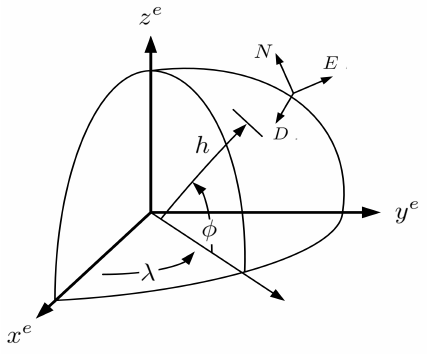
Figure 4. Earth-Centered Earth-Fixed co-ordinate